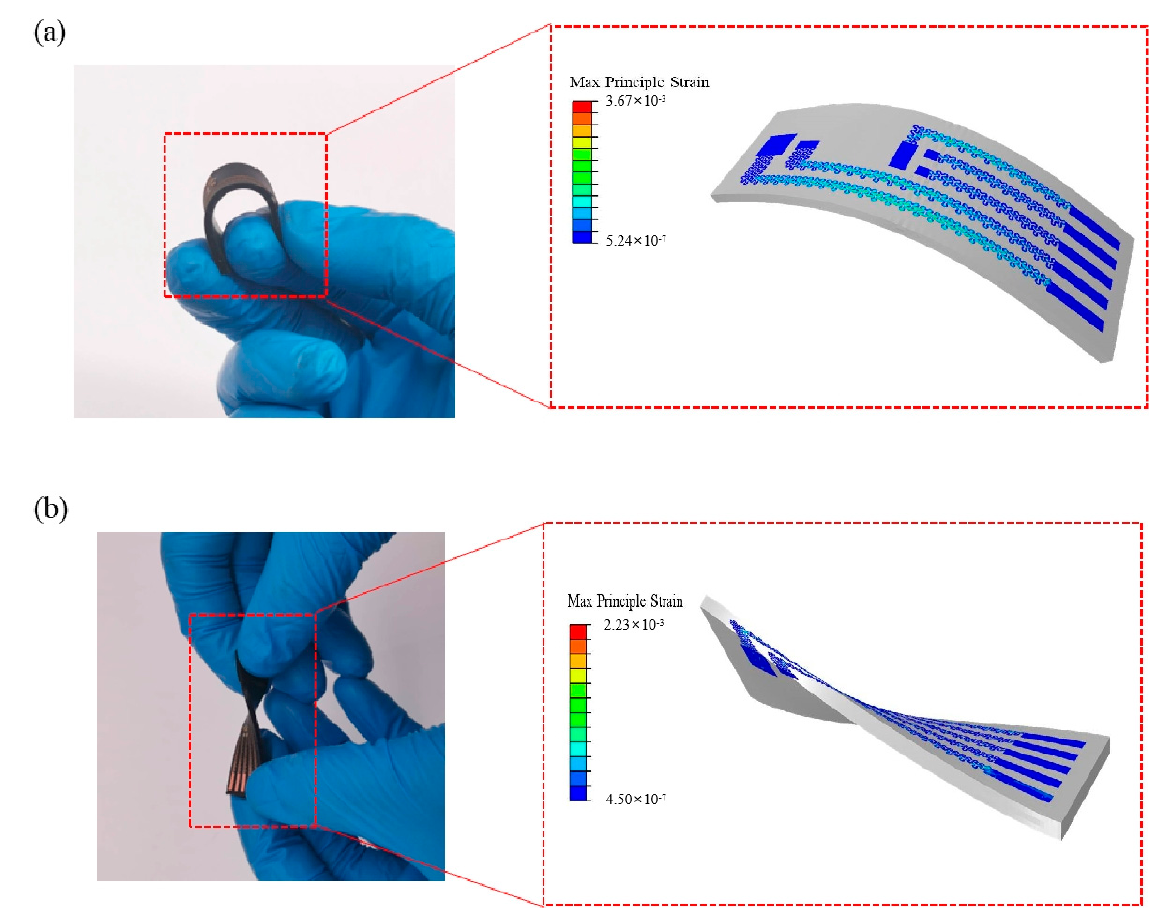
Figure 3. Optimized mechanics for the flexible device. ( a ) Strain distribution calculated by FEA in the copper layers of the device with a bending radius of 3 cm. ( b ) Strain distribution of the copper layer for a device with a torsion angle of 40°.